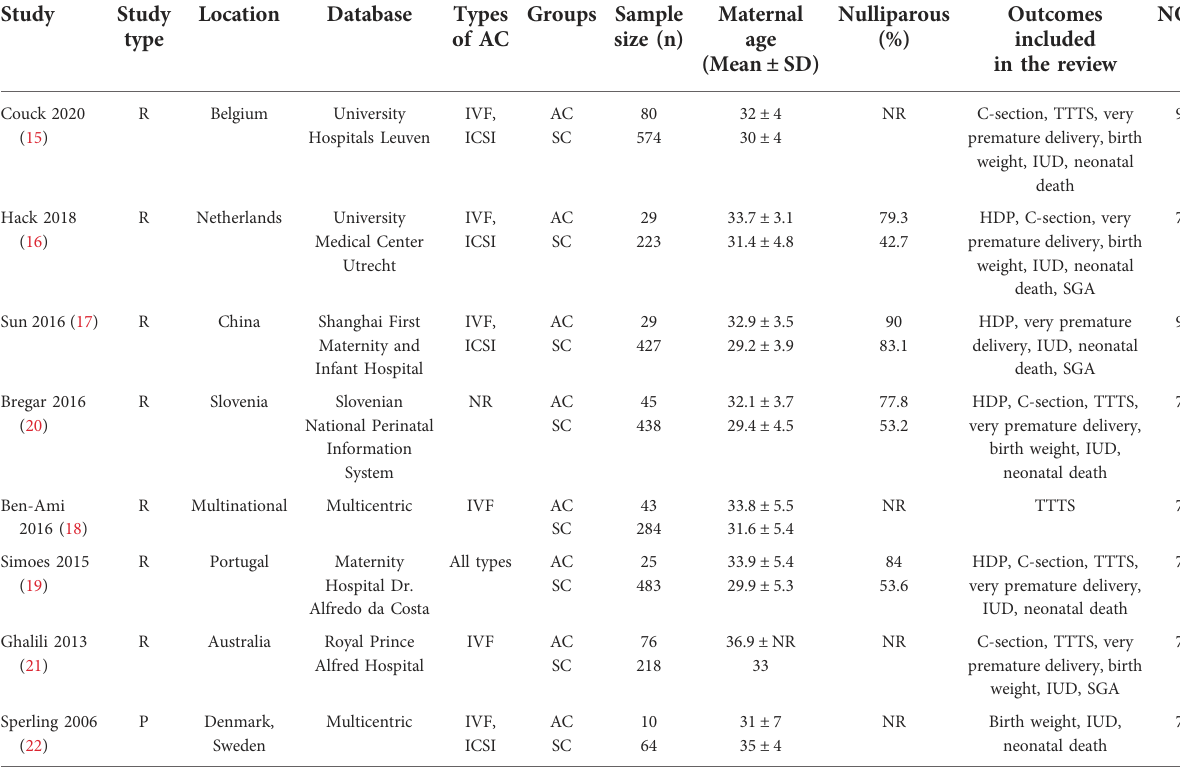
TABLE 1 Details of included studies.